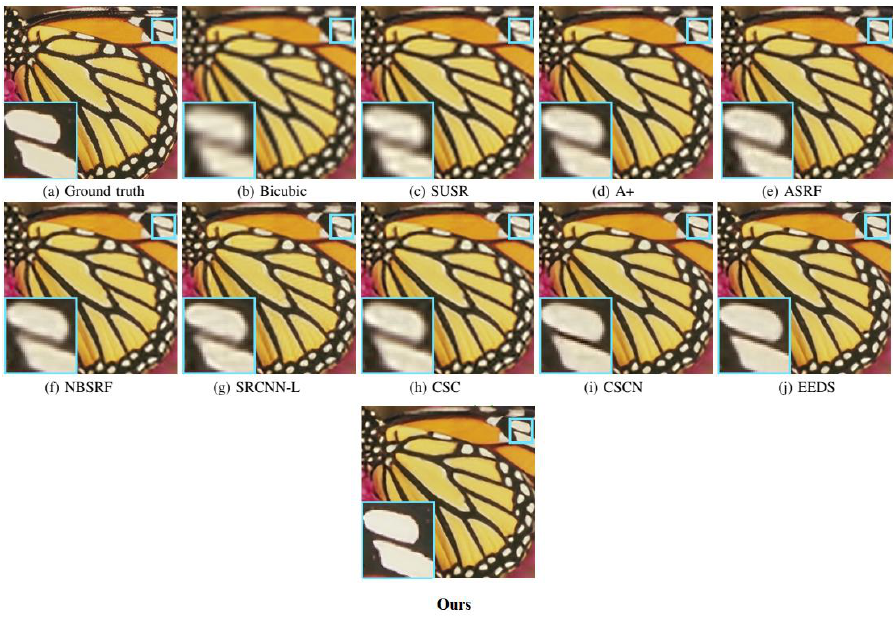
Figure 6. The “butterfly” image from Set 5 with an upscaling